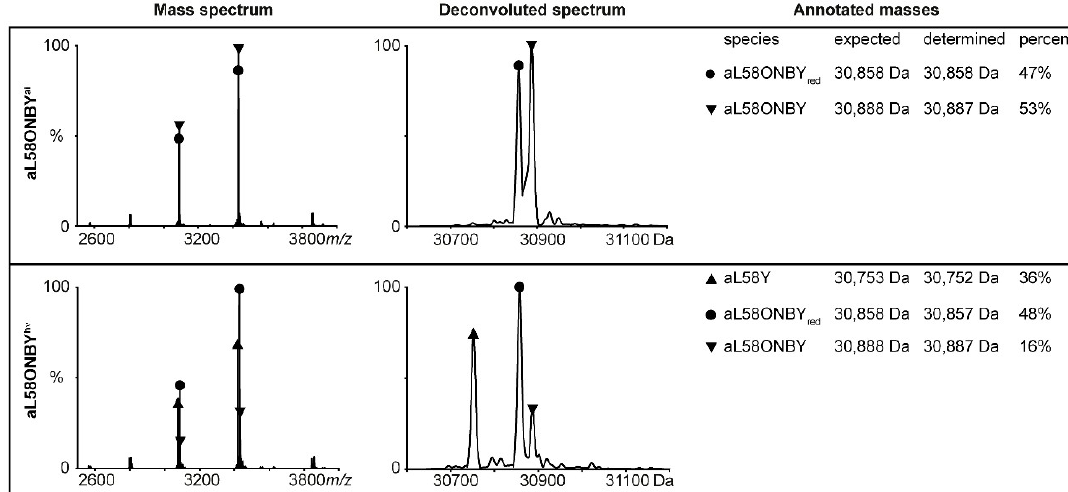
Figure 4. Native MS analysis of aL58ONBY ai (upper panel) and aL58ONBY hν (20 min irradiation at 365 nm; bottom panel). Three species—caged aL58ONBY, decaged aL58Y, and aL58ONBY reduced at the nitro group (“red”)—were detected.